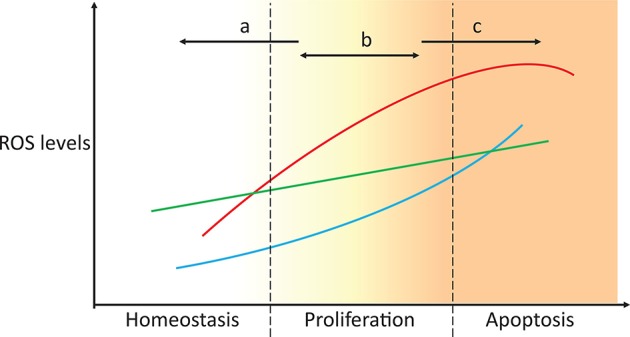
Targeting ROS homeostasis as a strategy for changing cell fate. In proliferative conditions, such as cancer, targeting antioxidant systems could move the redox state of the cell to either promote normal redox homeostasis or apoptosis (strategies a and c, respectively). Unsuccessful tackling of antioxidant metabolism results in the cells maintaining a proliferative state, which potentially enhances malignancy. The three lines represent the high heterogeneity between individuals, tissues, and cancer types.